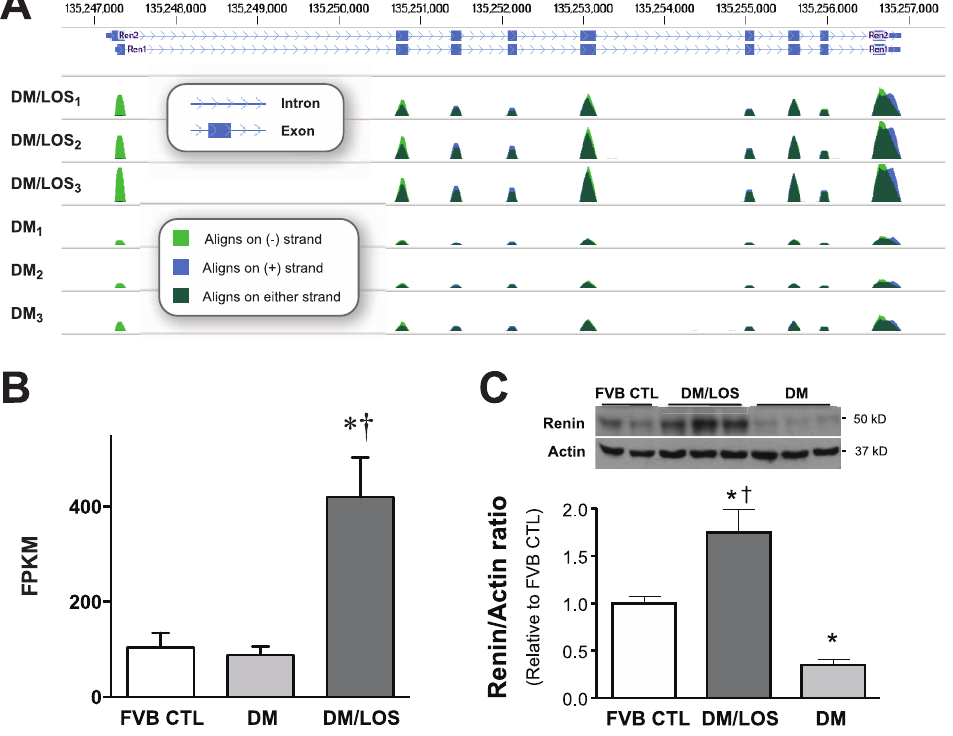
Figure 2. Data format and assay validation. Depiction of data alignment with canonical mouse genome at the Ren1 (renin) locus showing the effect of losartan treatment on renin expression. A . Data from individual biological replicates (numbered as subscripts 1 through 3 for conditions DM and DM/LOS) are shown. Peaks (dark green) correspond to transcripts aligning with exons (blue boxes at top) within the Ren1 gene; peak height reflects transcript abundance. At this resolution, individual transcript mappings are not discernible. B . Graphical depiction of data reflecting normalized renin mRNA abundance under each of the three experimental conditions. (Note that raw data for CTL are not shown in A .) These data are consistent with effective angiotensin-receptor blockade in the losartan-treated diabetic mice. C . Renal expression of renin protein in lysates prepared from kidneys of non-diabetic FVB mice and in OVE26 diabetic mice with (DM/LOS) or without (DM) treatment with losartan. Densitometric data are presented as renin to actin (loading control) ratios expressed, relative to FVB control (means 6 SD). Representative blot is shown in the inset. *p , 0.05 vs. FVB non-diabetic control; { p , 0.01 vs. OVE26 (diabetic state).